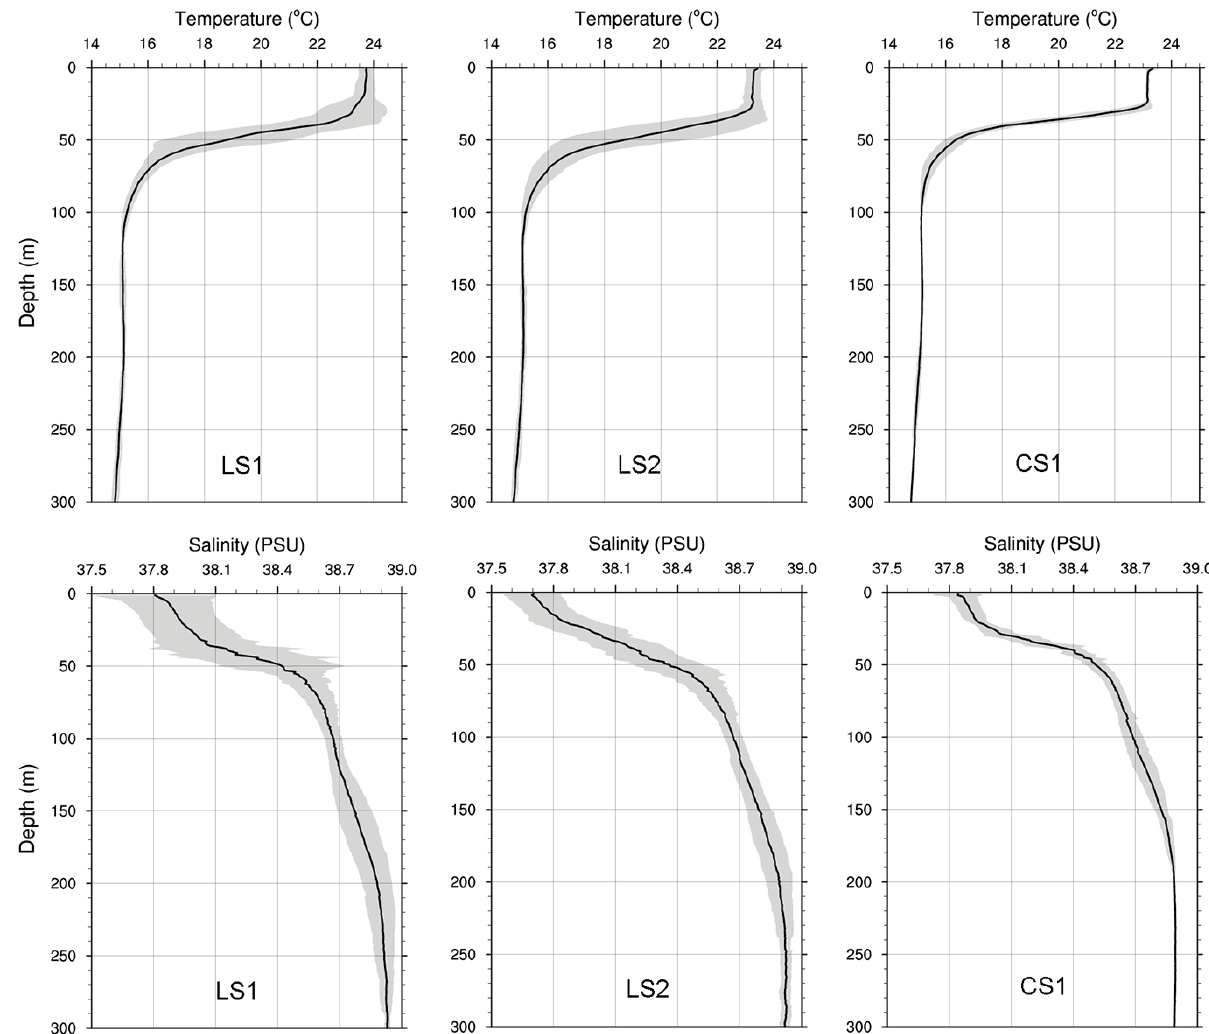
Figure 4. The station average temperature and salinity profiles for LS1 (left column), LS2 (central) and CS1 (right column) surveys. The grey shaded areas represent standard deviations of the survey station profiles from the